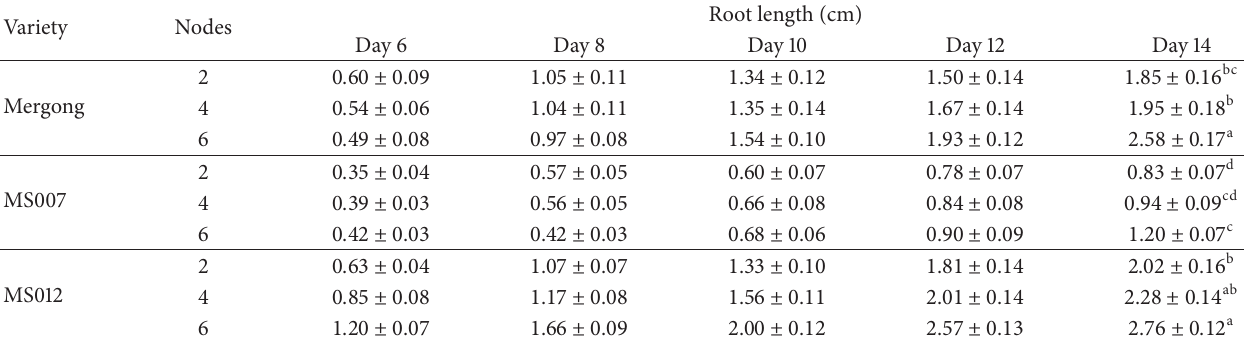
Table 2: Mean root length of three varieties having 2, 4, and 6 nodes cuttings from day 6 to day 14. Variety